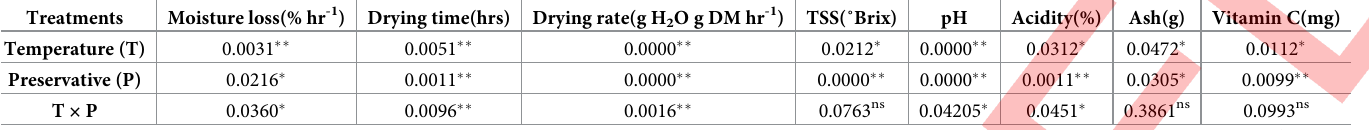
Table 2. Probabilty and significance for moisture loss, drying time, drying rate, total soluble sugars, pH, acidity, ash contents and vitamin C of persimmon fruit subjected to different drying temperatures and preservatives. Treatments